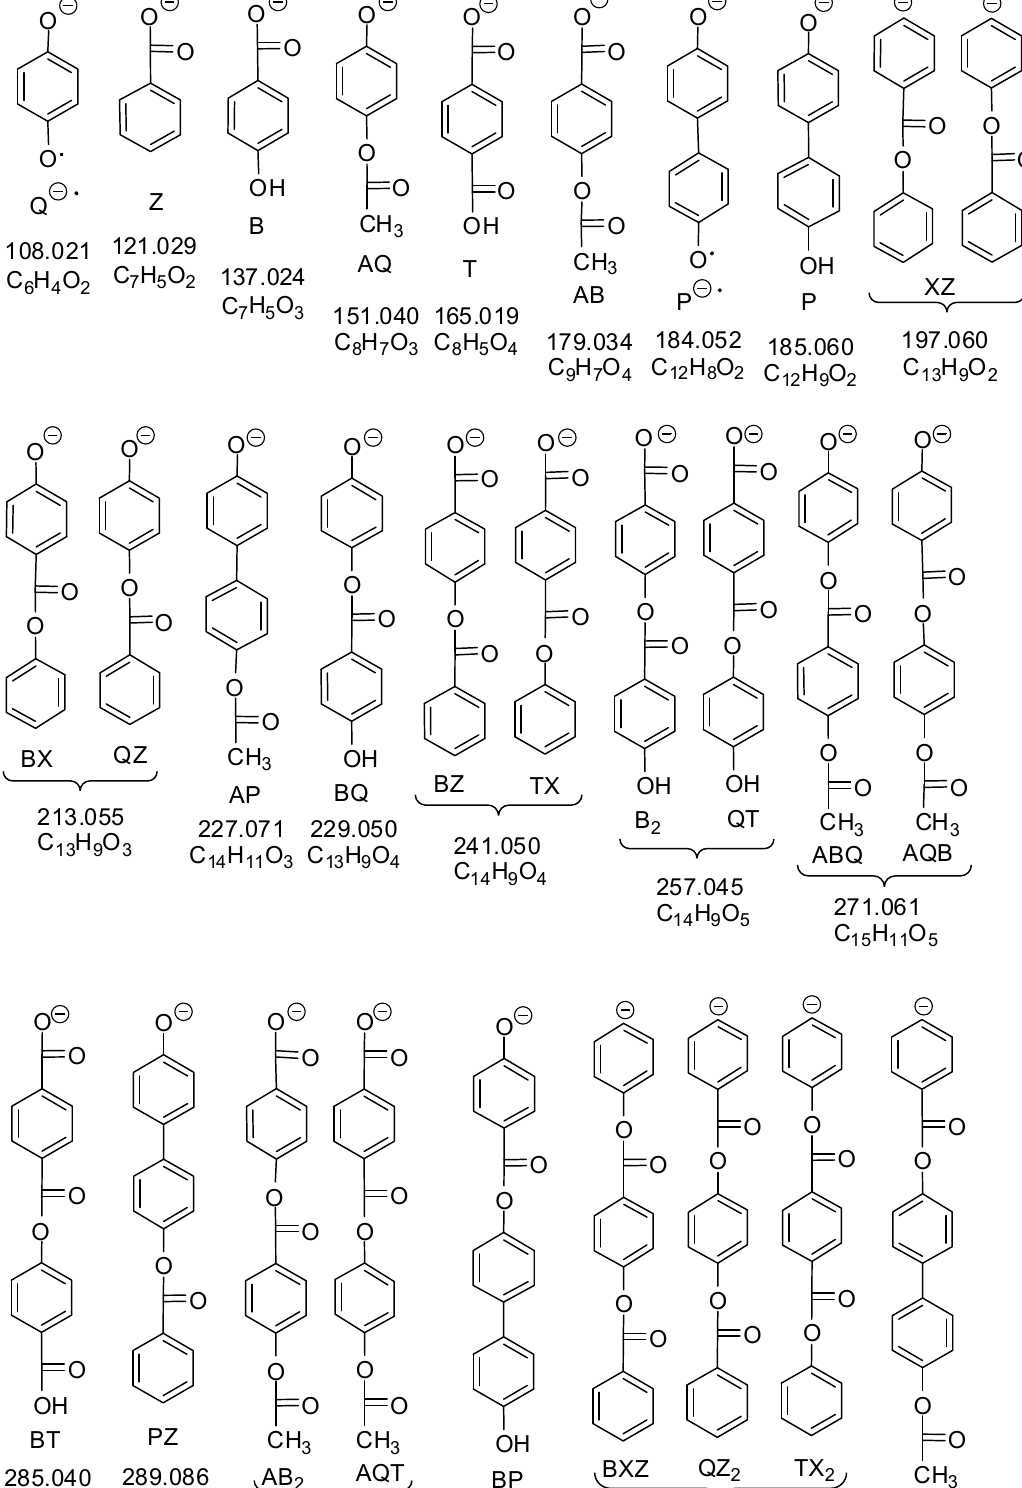
Table 4. Possible structures of anions in Table 3 with molecular weights from 108 to 331 held together by ester bonds only ; structures with molecular weights from 332 to 500 are shown in the Supplementary